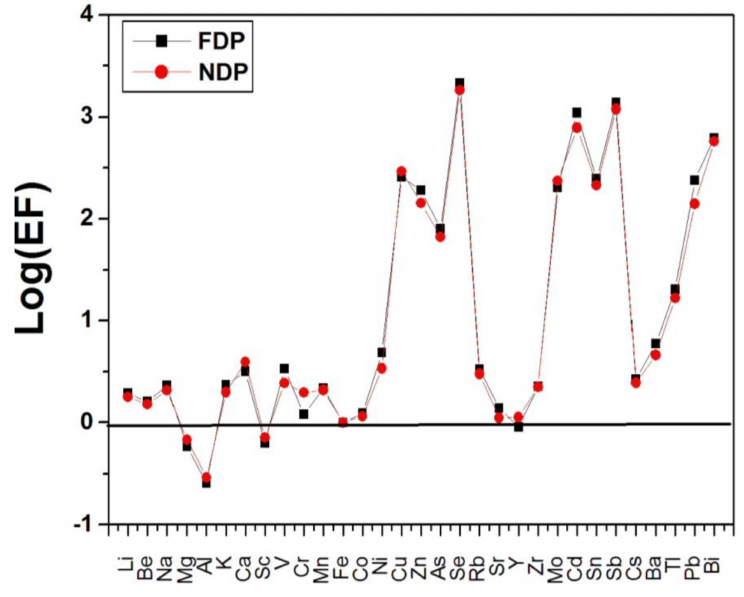
Figure 4. Logarithms of enrichment factors for 31 selected metals collected during FDP and